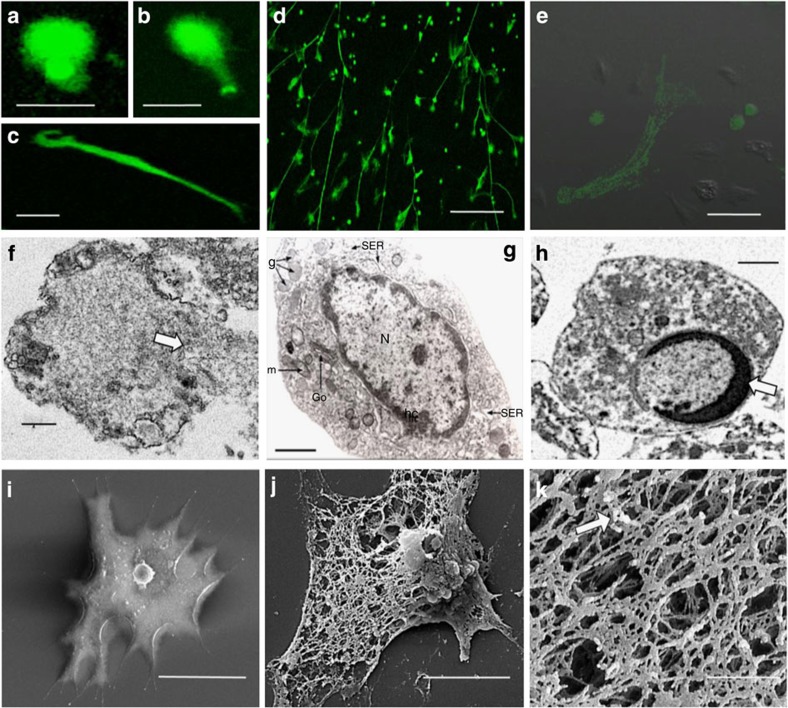
Chromatin discharge by separated HCs from C. maenas in vitro.(a–e) Unfixed HCs in monolayer cultures stained with Sytox Green. (a,b) Diffuse extracellular chromatin at 3 h, 1.0 μM PMA. (c) Spread extracellular chromatin at 24 h, 0.1 μM PMA. (a–c) Scale bar, 30 μm. (d) Extended extracellular chromatin strands (24 h, 0.1 μM PMA ). Scale bar, 300 μm. (e) Merged phase contrast and fluorescence images of an ETotic HC at 24 h (0.1 μM PMA). Also evident are viable cells and stained necrotic/late apoptotic cells with round stained nuclei. Scale bar, 50 μm. (f) TEM of a HC (24 h, 0.1 μM PMA) showing swelling of uncondensed chromatin, nuclear membrane breakdown and chromatin discharge from the cell at a breach point (arrow). (g) TEM of a control, unstimulated HC, N, nucleus with intact membrane and rim of condensed heterochromatin (hc) at the periphery. Go, Golgi body, g, granules, m, mitochondrion, SER, smooth endoplasmic reticulum. (h) TEM of an apoptotic HC showing an intact nuclear membrane with a thick, crescent shaped rim of condensed chromatin (arrow). (f–h) Scale bars, 1 μm. (i) SEM of control HC. Scale bar, 20 μm. (j) SEM of ETotic HC (24 h, 0.1 μM PMA). Scale bar, 5 μm. (k) SEM detail of extracellular chromatin released from a HC (24 h, 0.1 μM PMA). Arrow indicates granules studded on the extracellular mesh. Scale bar, 1 μm.